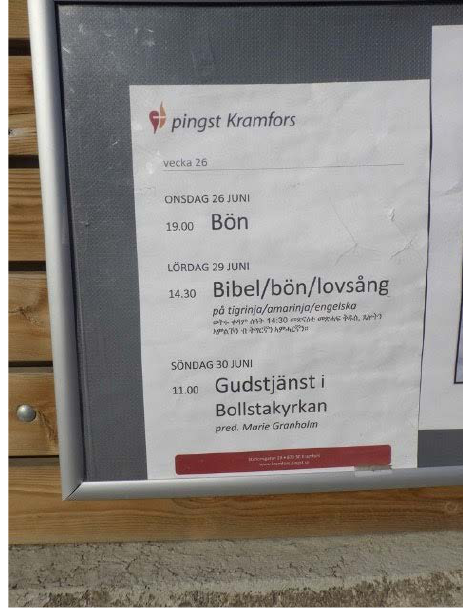
Figure 5. Church Notice Board .